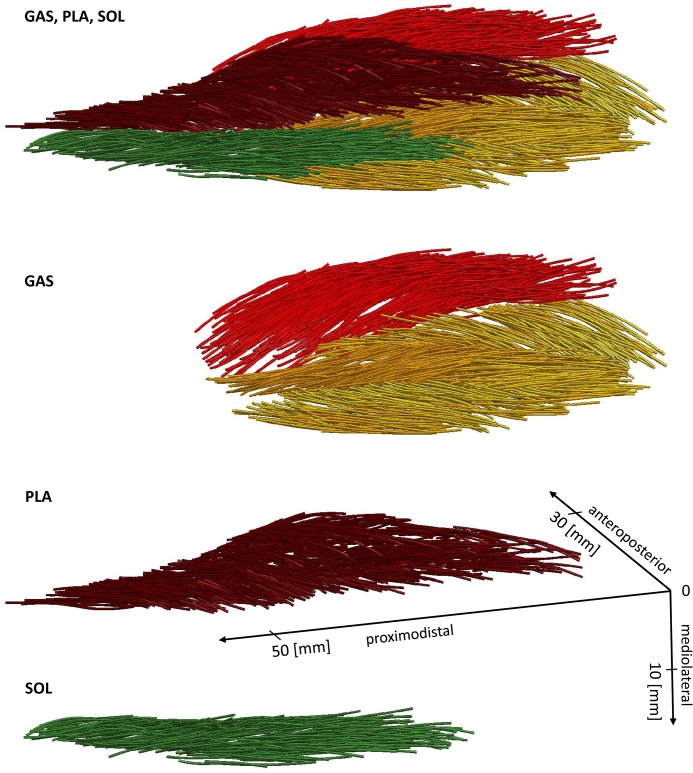
Muscle architectures of GAS, PLA, and SOL of R1 left pelvic limb.Muscle fascicles of GAS medialis and lateralis are shown in light red and yellow, respectively. The proximodistal axis corresponds to the mean force axis of the calf muscles, running from mean muscle origin at the humerus to the insertion at the calcaneus. The corresponding 3D data of the muscle fascicles are provided in the Supporting Information (S2–S4 Datasets).